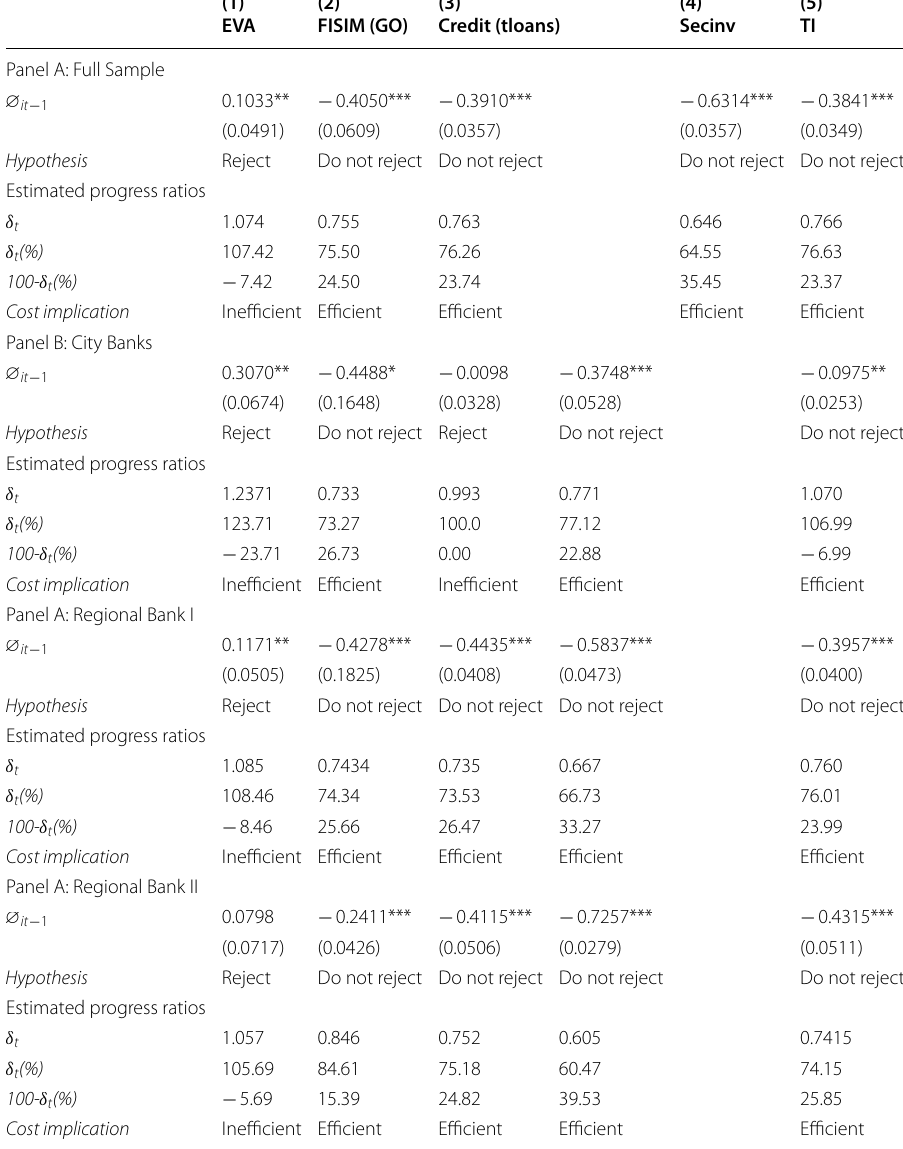
Table 3 Estimated